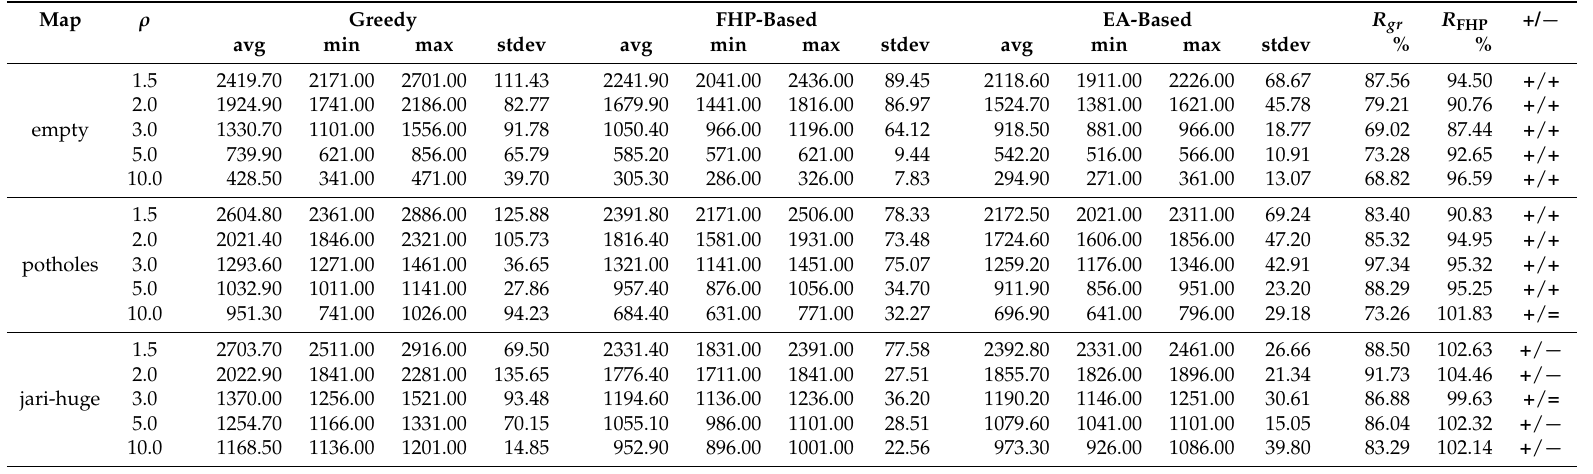
Table 1. Comparison of the exploration